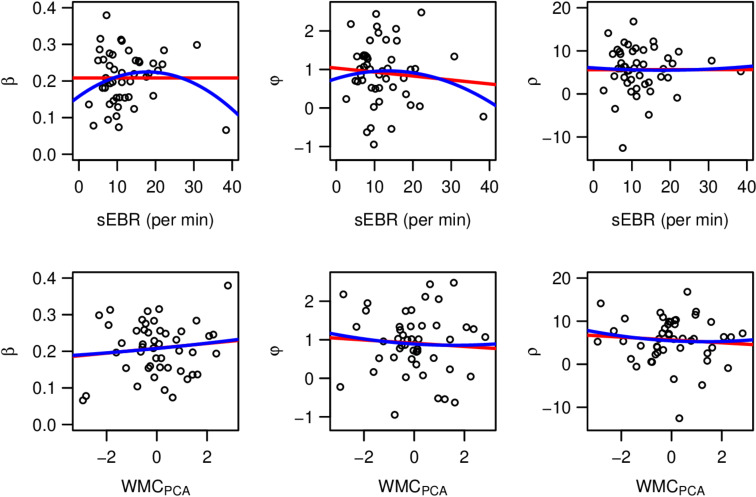
Test for an inverted-U relationship between DA baseline proxy measures (spontaneous eye blink rate (sEBR) & working memory capacity (WMCPCA)) and the posterior medians of the three choice parameters (β,φ,ρ) of the winning (Bayes-SMEP) model.Model parameters: β: softmax parameter; φ: exploration bonus parameter; ρ: perseveration bonus parameter.